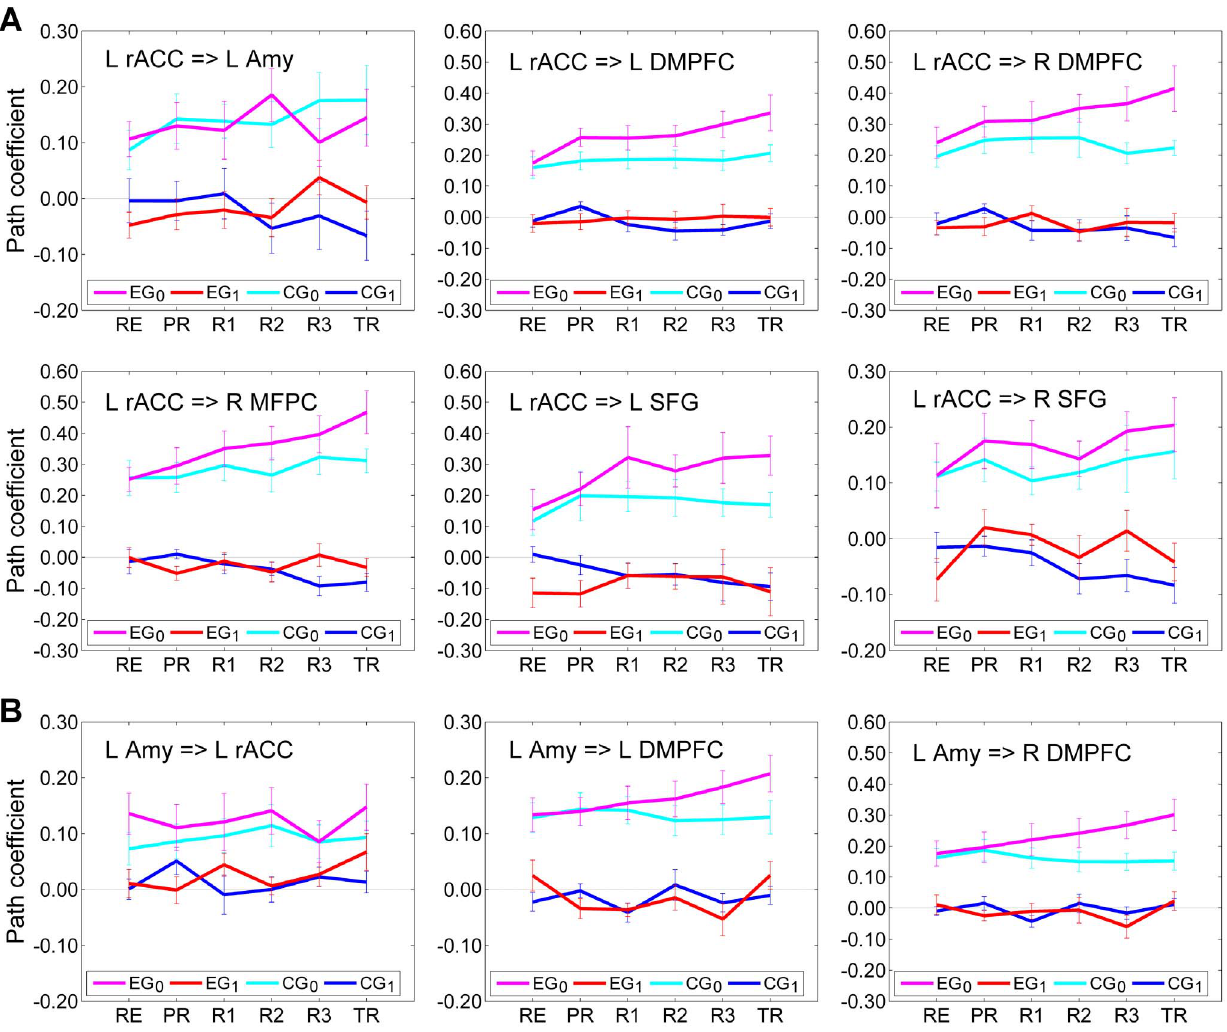
Figure 6 . Interactions suggested by the multivariate SVAR analyses for seven ROIs. (A) Results of the multivariate first-order structural vector autoregression (SVAR) analysis for the network of seven ROIs using a star model for instantaneous effects of the left rACC (Fig. 5A). (B) Results of a similar SVAR analysis using a star model for instantaneous effects of the left amygdala. For the experimental group (EG), average path coefficients (mean 6 sem) for the instantaneous effects are depicted in magenta and denoted EG 0 , and those for the lagged effects are depicted in red and denoted EG 1 . For the control group (CG), average path coefficients for the instantaneous effects are shown in cyan and denoted CG 0 , and those for the lagged effects are shown in blue and denoted CG 1 . doi:10.1371/journal.pone.0079184.g006 and Fig. 5C, respectively. For Model I, the average x 2 value (mean 6 std) over three neurofeedback runs (Run 1, Run 2, Run 3) for 14 subjects in EG was x 2 = 0.005 6 0.016. For Model II, this average value was x 2 = 0.006 6 0.020. These values with df = 2 correspond to P = 0.9975 and P =0.9970, respectively, indicating that both models provided excellent fits to the instantaneous effects in the experimental time series data for the three ROIs. Figure 7 exhibits average values of the path coefficients (mean 6 sem) in Model I and Model II. The instantaneous effects common to both Model I and Model II are shown in Fig. 7A, while the effects specific to each of the two models are shown in Fig. 7B and Fig. 7C, respectively. The corresponding linear trend statistics across the neurofeedback runs (RE…R3) are included in Table 4. According to these data, the instantaneous effects of the left rACC and the LA on the right DMPFC for EG exhibited significant positive linear trends (rACC= . R DMPFC: